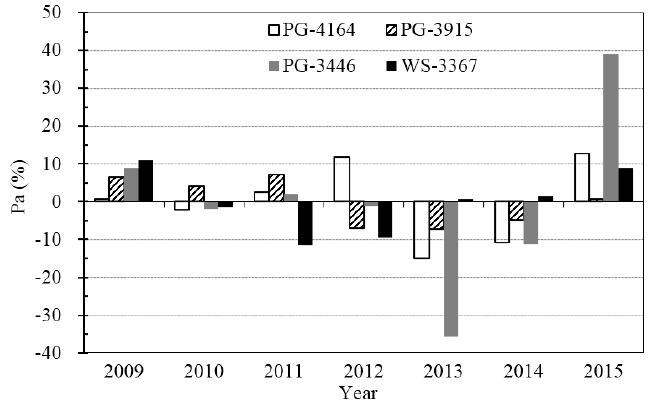
Figure 2. Pa of annual precipitation from 2009 to 2015.